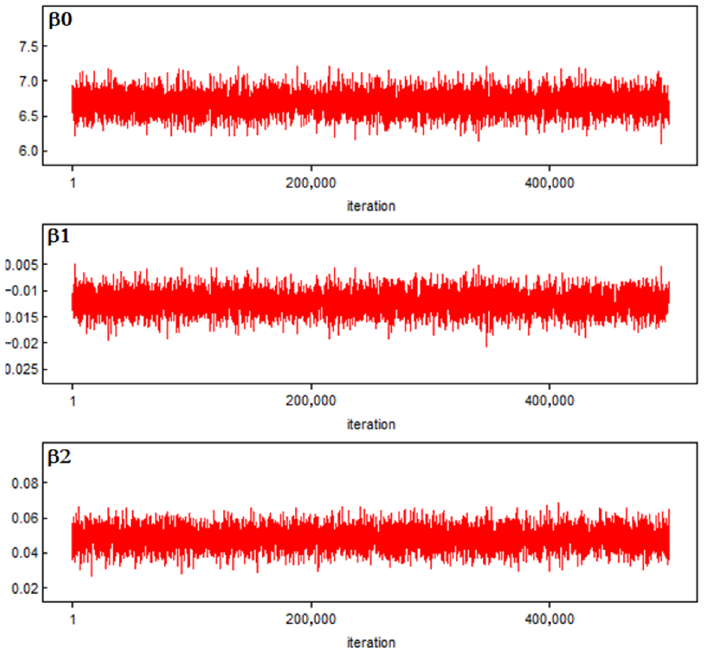
Figure 6. History plot of MCMC estimation.